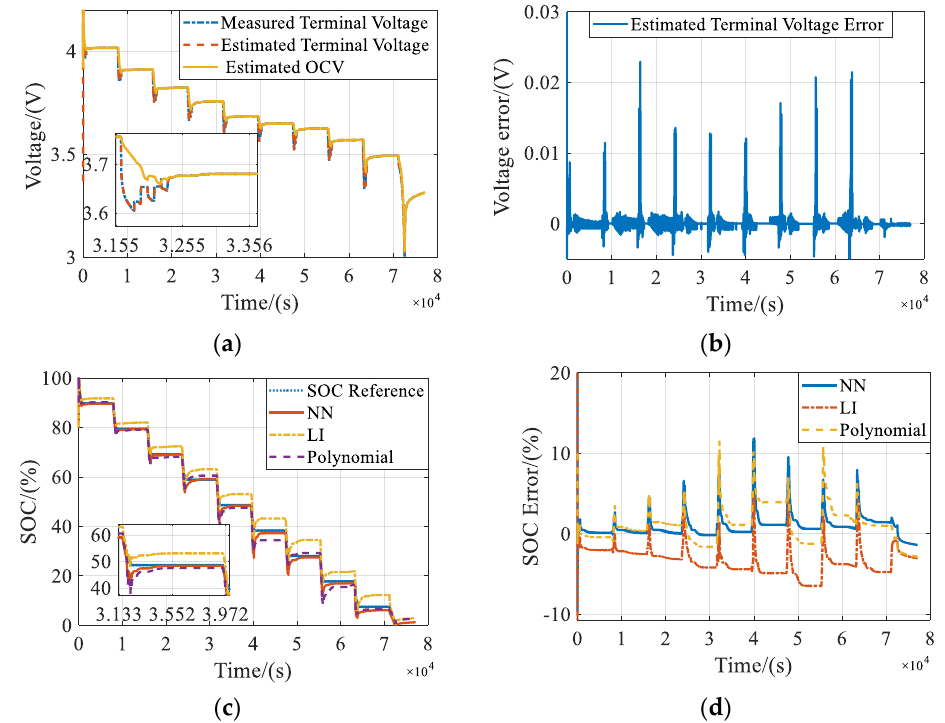
Figure 8. Comparison of different OCV construction methods in dynamic current discharge test. ( a ) Terminal voltage and OCV estimation result. ( b ) Estimation error of terminal voltage. ( c ) Comparison of SOC estimation result. ( d ) Comparison of SOC estimation error.